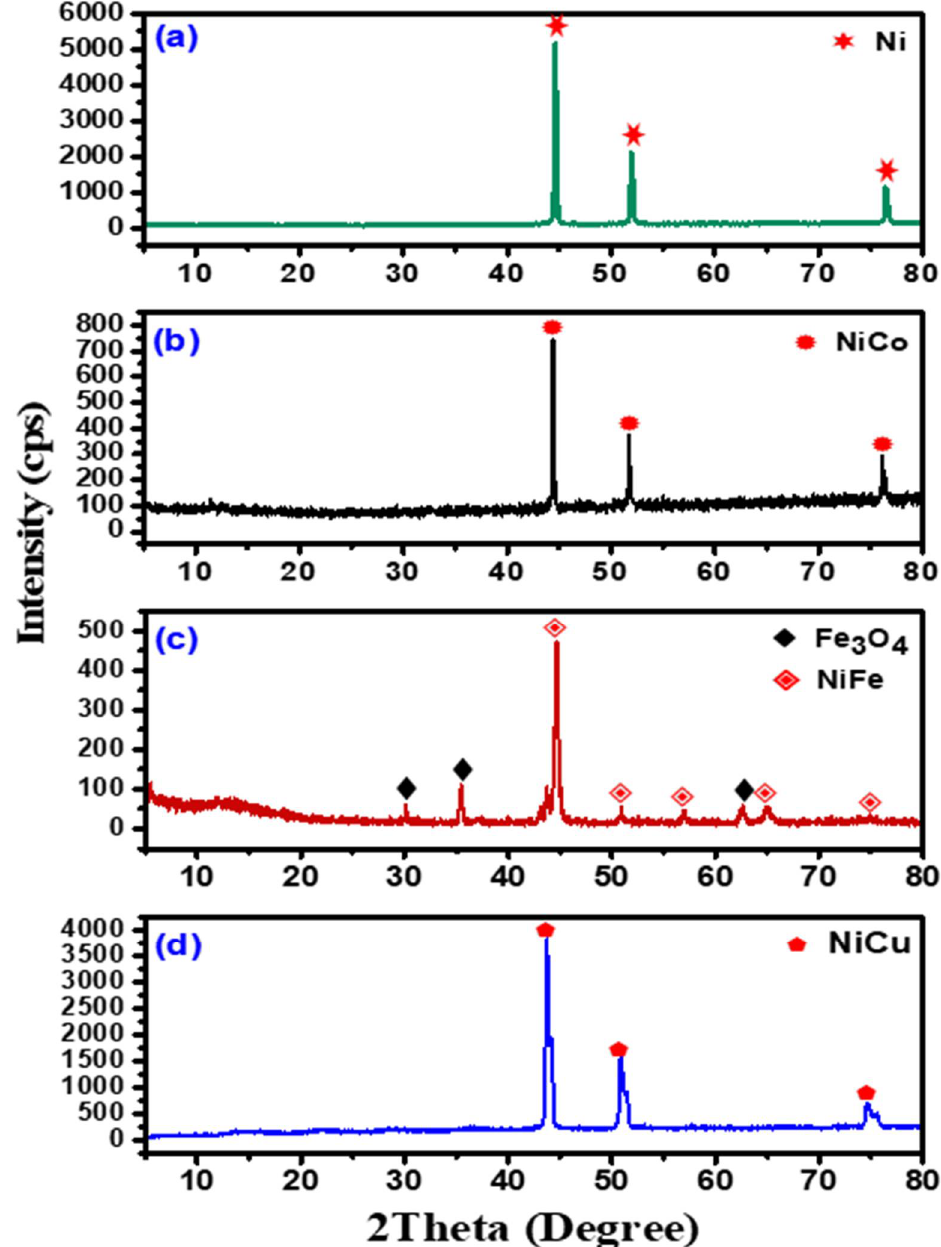
Figure 5. XRD patterns of the reduced samples: ( a ) Ni, ( b ) Ni-Co, ( c ) Ni-Fe, and ( d ) Ni-Cu.